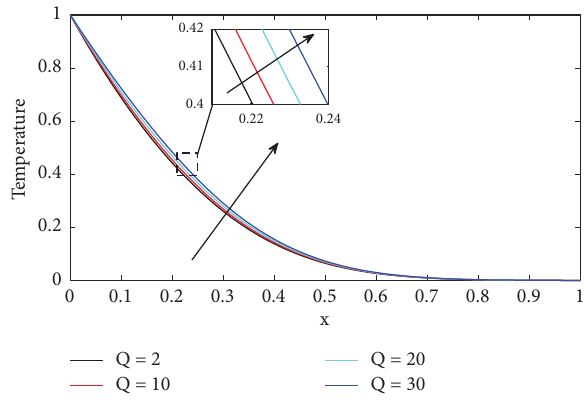
Figure 20: Temperature profles for diferent values of Q .